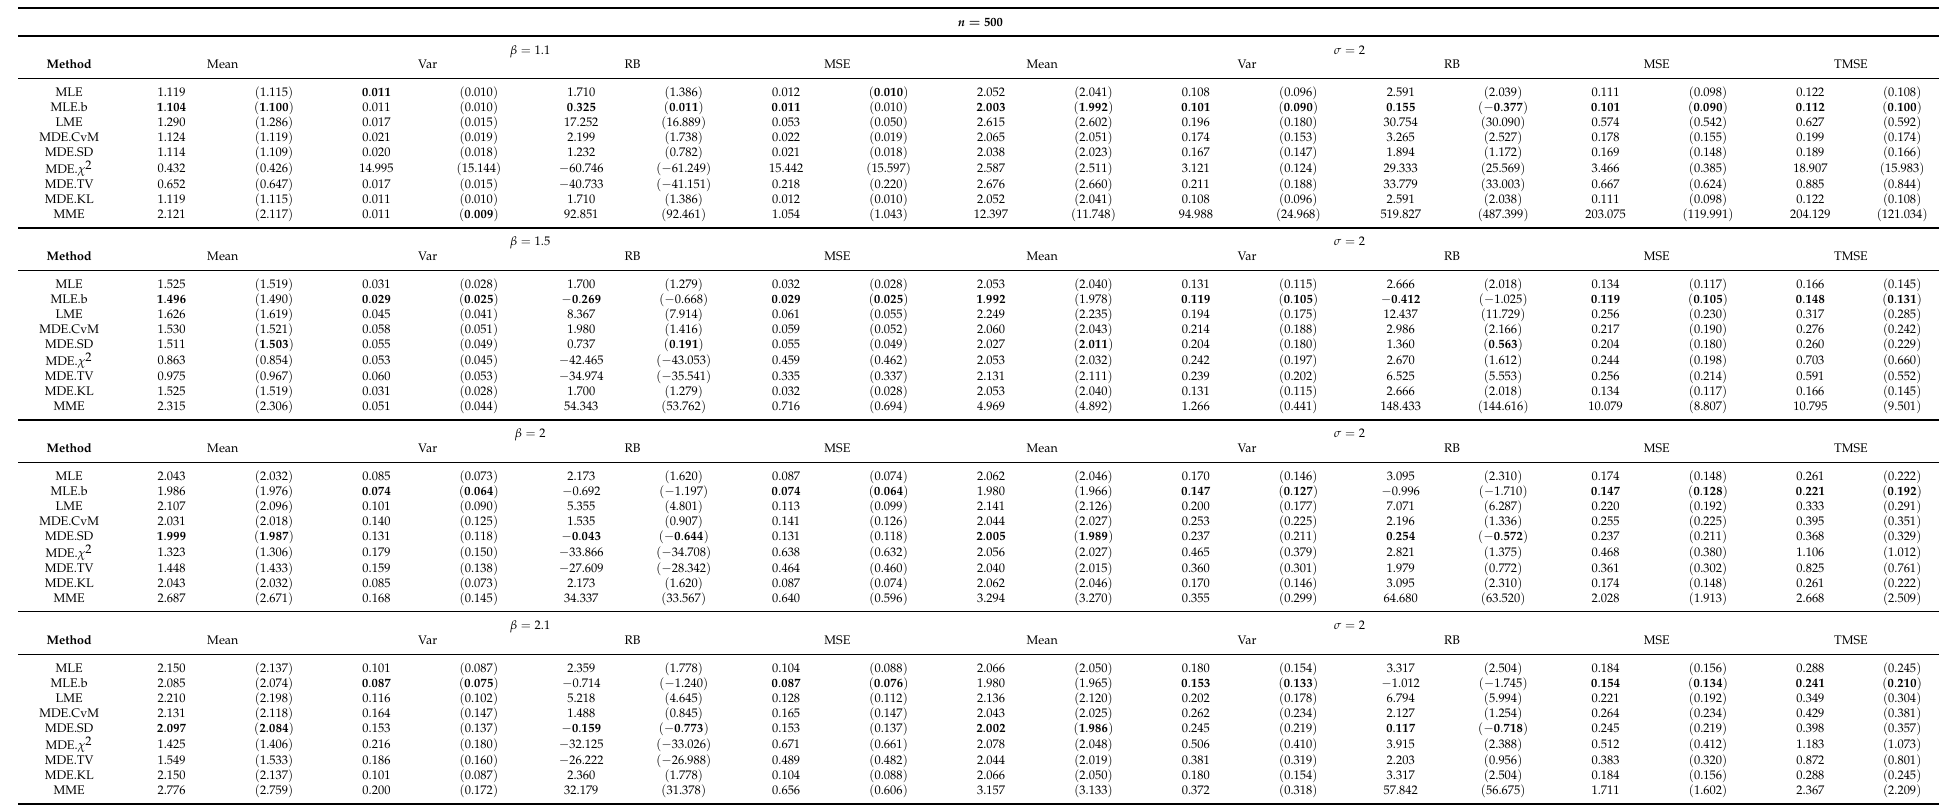
Table A6. Comparison of different estimation methods for different values of β ( σ = 2 and n =